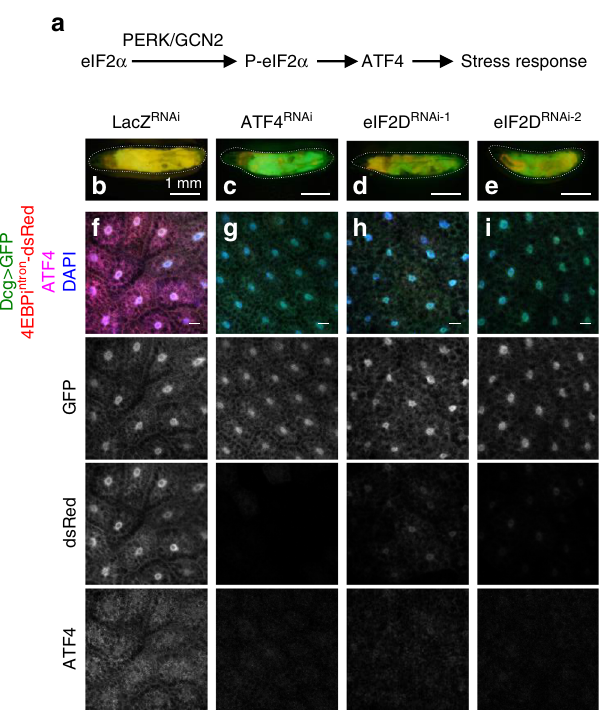
Fig. 1 An RNAi screen to identify genes required for ATF4 translation. a Line diagram summarizing the ISR pathway in Drosophila . b – e Third instar larvae expressing 4E-BP intron -dsRed reporter with indicated RNAi lines and UAS-GFP driven by the fat body speci fi c Dcg-Gal4 . Individual larvae are outlined with dotted lines. Scale bars represent 1 mm. f – i Fat body tissues dissected from larvae in b – e expressing GFP (green), dsRed (red), immunolabeled with antiATF4 antibody (magenta) and DAPI (blue). Scale bars represent 25 μ m unless otherwise indicated here and in subsequent fi gures. Data in b – i are representative images collected from two independent biological experiments with ten animals in each